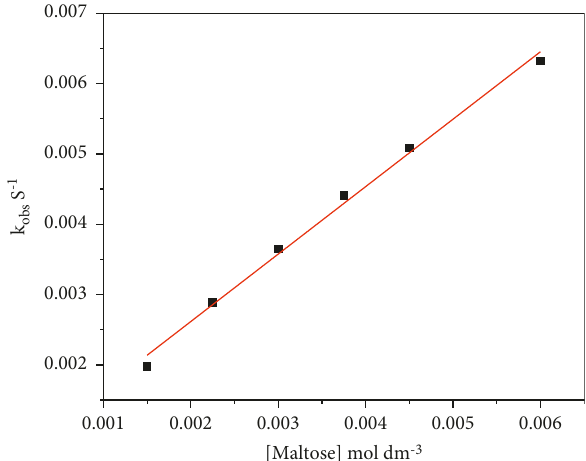
Figure 2: k obs versus [Maltose] at the following conditions: